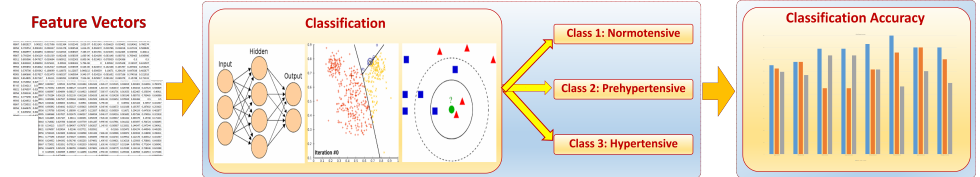
Figure 6. Module 3: Classification of data into normal, prehypertensive, and